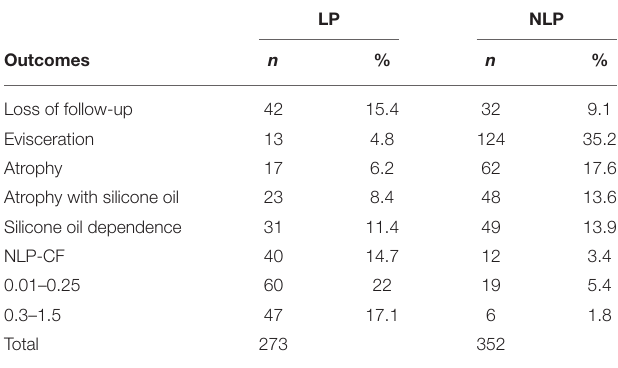
TABLE 4 | Final outcomes of 625 eyes with severe OGIs.